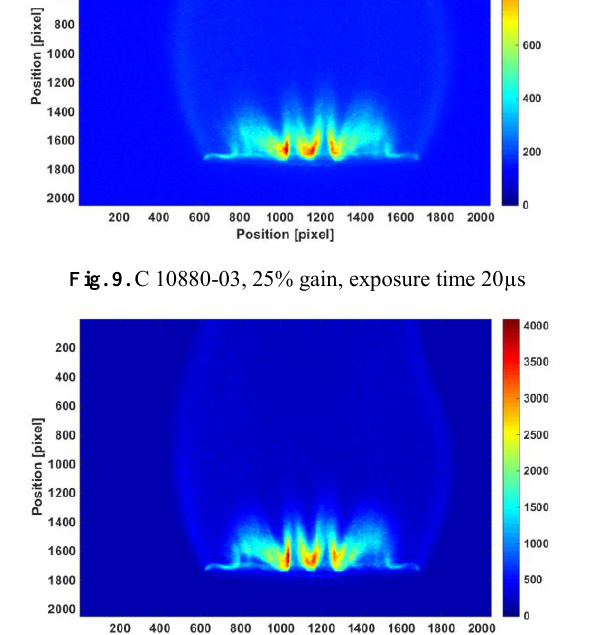
Fig. 12. C 10880-03, 60% gain, exp. time 300µs,